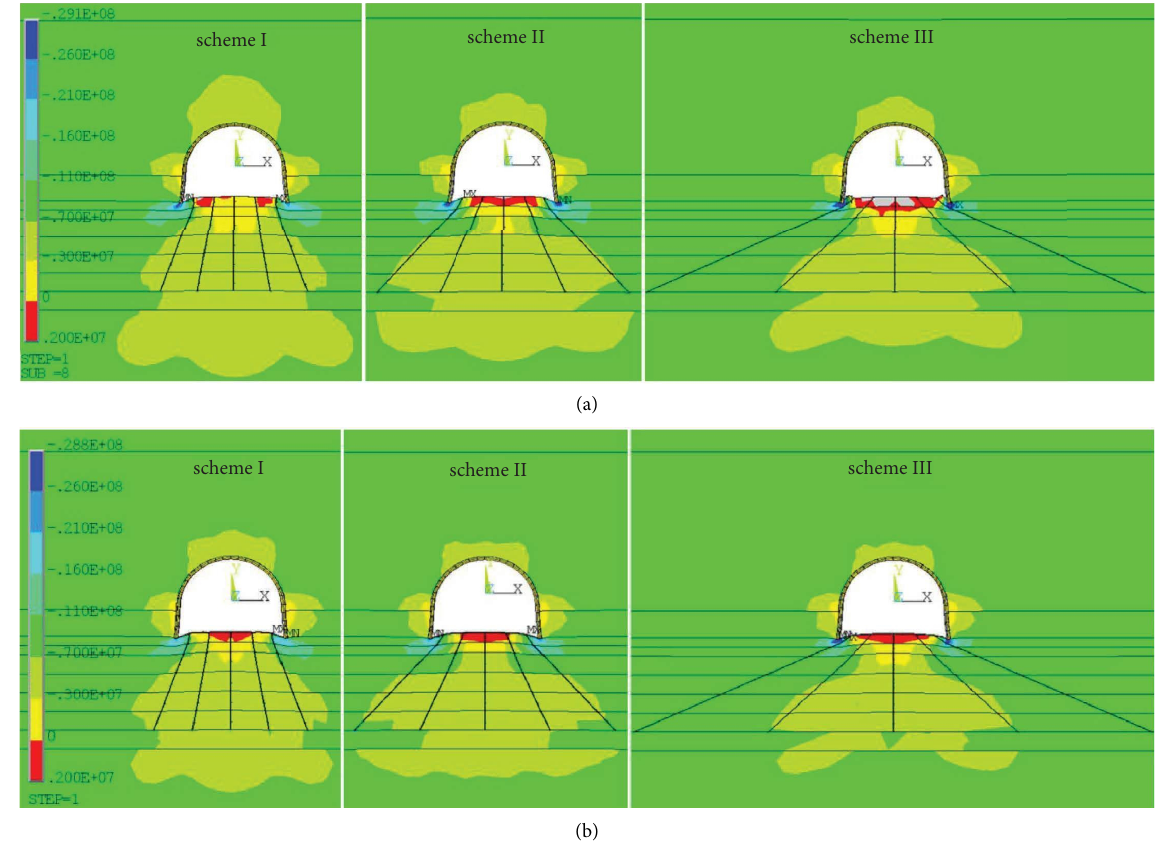
Figure 16: Maximum principle stress distribution around the roadway after foor bolting: (a) rock bolts without additional supporting elements; (b) rock bolts with steel